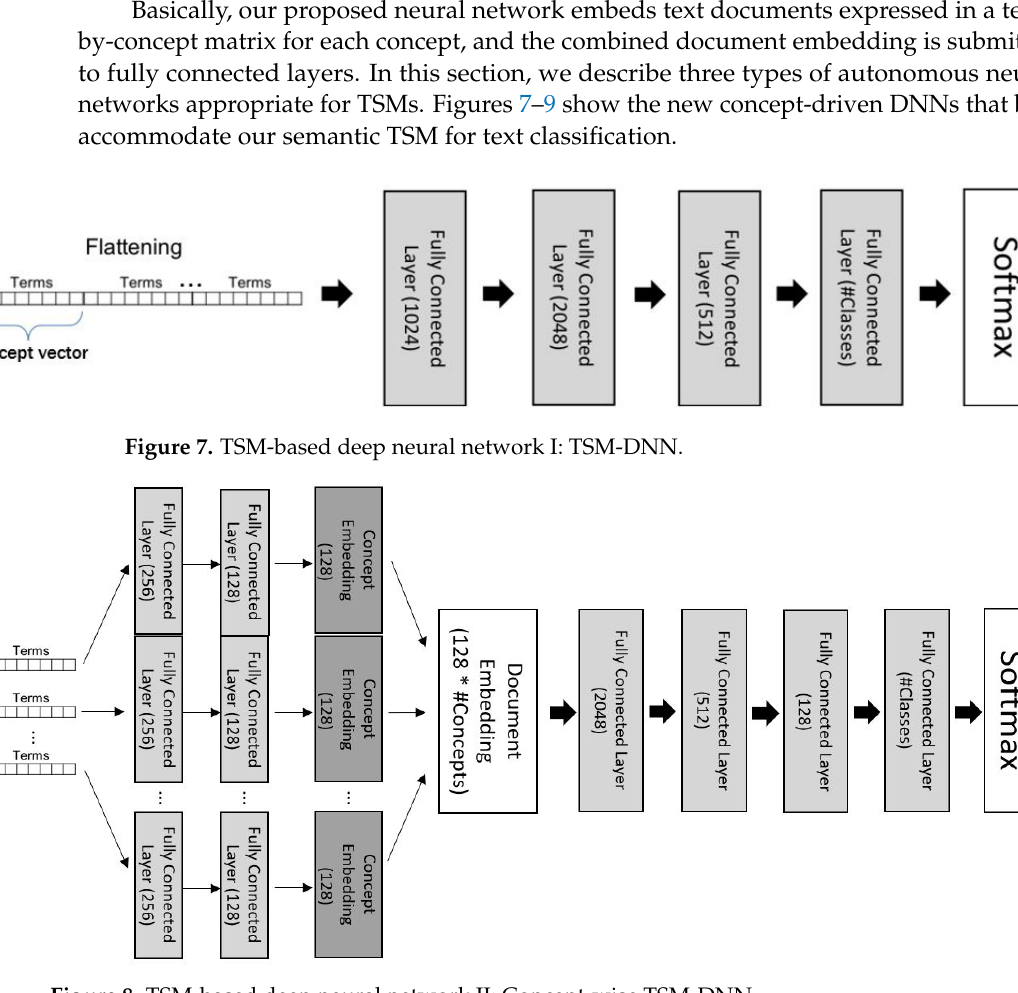
Figure 8. TSM-based deep neural network II: Concept-wise TSM-DNN.